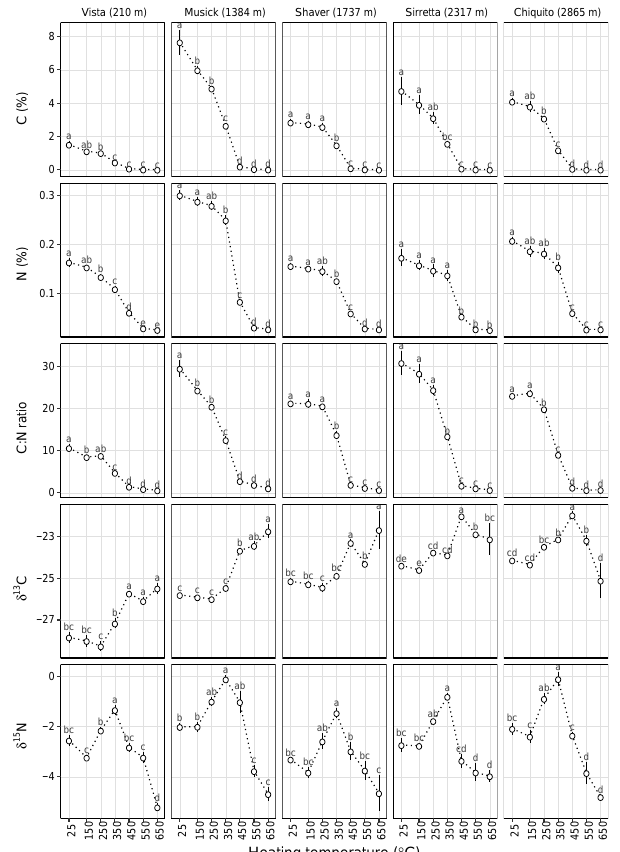
Figure 2. Bulk soil carbon and nitrogen concentrations, C:N atomic ratio, and δ 13 C and δ 15 N isotope (‰) changes with an increase in heating temperature. Error bars represent standard er- ror, where n = 3. Different letters represent significantly different means ( p < 0 . 05) at each temperature after Tukey’s HSD